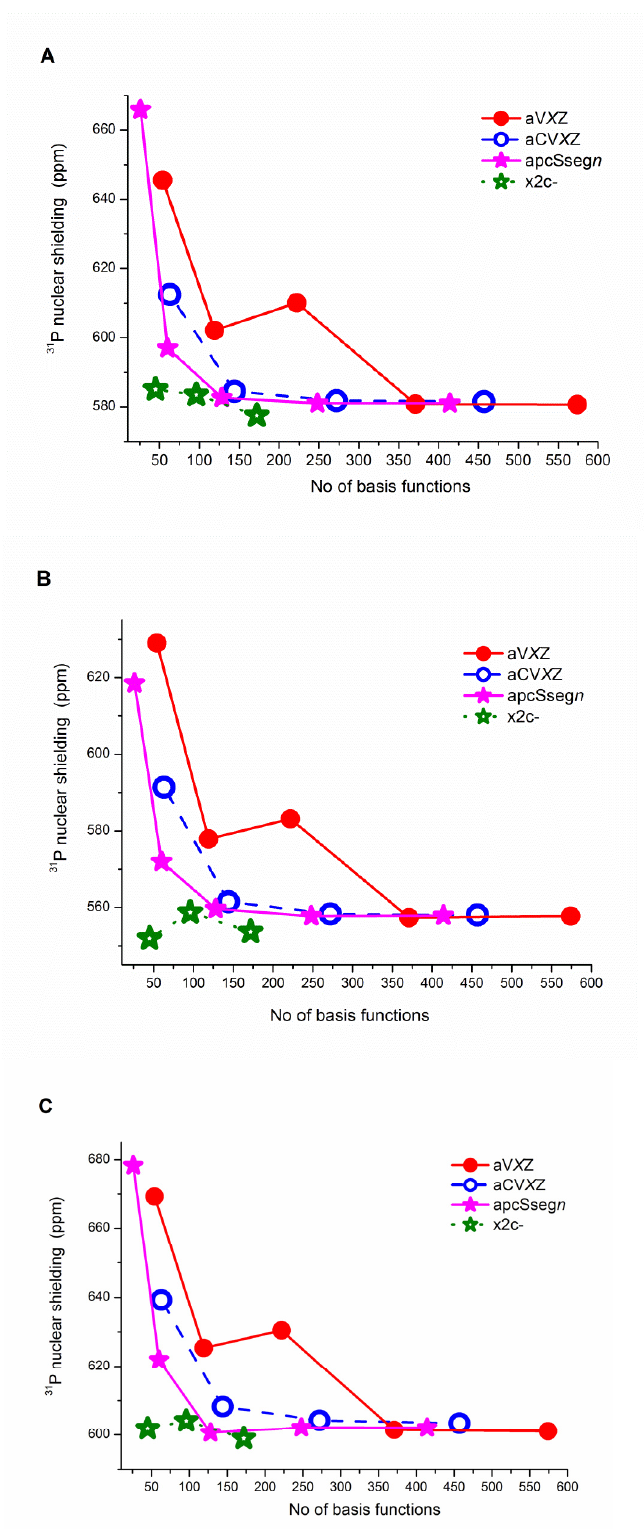
Figure 1. Convergence of 31 P isotropic shielding constants for PH 3 vs. the number of basis functions, calculated with the ( A ) HF-SCF, ( B ) B3LYP and ( C ) CCSD(T) methods combined with the aug-cc- pV X Z, aug-cc-pCV X Z, aug-pcSseg- n and x2c- X ZVPall-s basis set